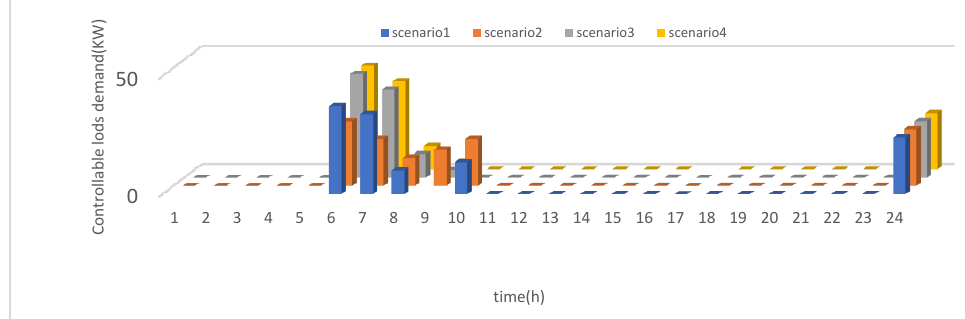
Figure 11. Controllable loads demand for all scenarios.